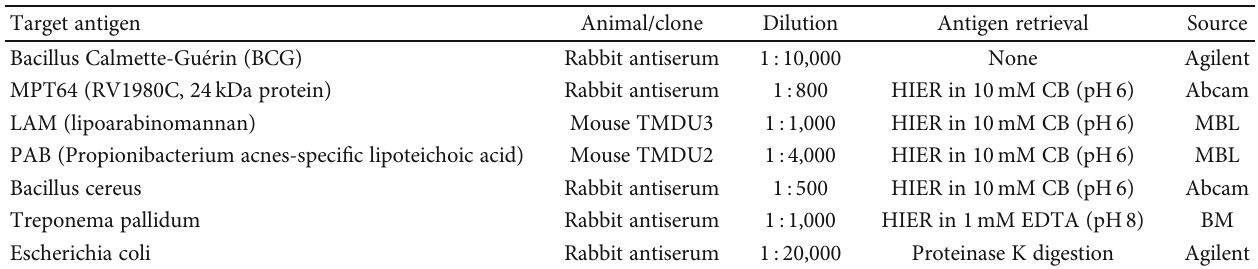
Figure 5: Colonies of Mycobacterium chelonae on 2% Ogawa medium ((a) gross appearance, (b) Ziehl-Neelsen stain, (c) Gram stain, and (d) MALDI Biotyper analysis). Smooth-surfaced white (nonchromogenic) colonies are formed seven days after inoculation. The formalin- fi xed, para ffi n-embedded colonies display acid-fastness and Gram reactivity of the rods. By the MALDI biotyping analysis, the spectrum pattern indicates M. chelonae with the log score value of 2.208. Table 1: Antibodies used in the present